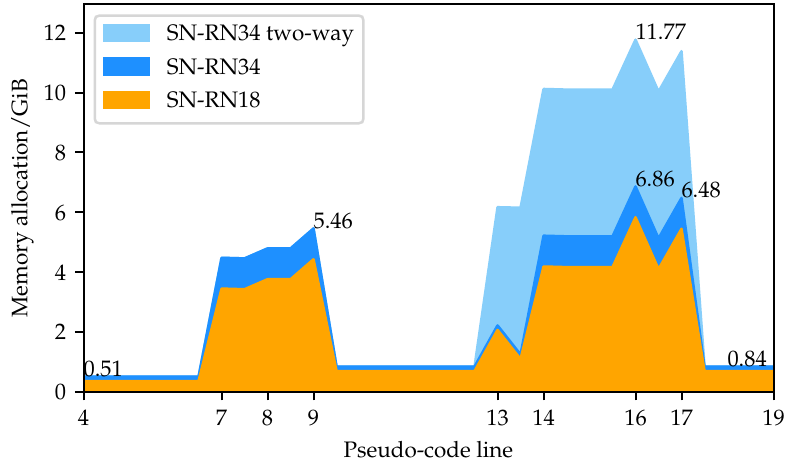
Figure 4. GPU memory allocation during and after execution of particular lines from Algorithm 1 during the 2nd iteration of training. Our PyTorch implementations involve SwiftNet-RN18 and SwiftNet-RN34 models with one-way and two-way consistency, 768 × 768 crops, and batch sizes ( B l , B u ) = ( 8,8 ) . Line 9 computes the supervised gradient. Line 13 computes the teacher output (without caching interemediate activations). Lines 16 and 17 compute the consistency loss and its